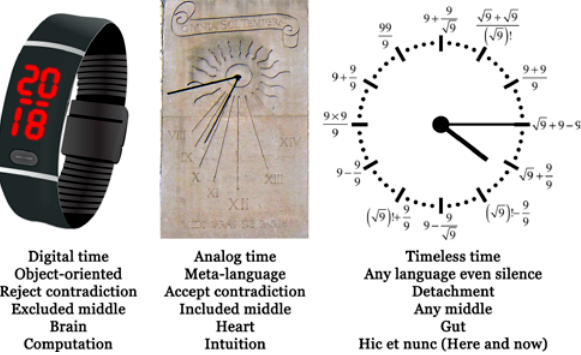
Figure 4. In our approach space and time are creation of con- sciousness and should be perceived along three different modalities according to the status given to the contradiction. The digital time is useful for a rational comprehension with the brain, the analog time for intuitive comprehension with the heart and the timeless time for immediate comprehension with the